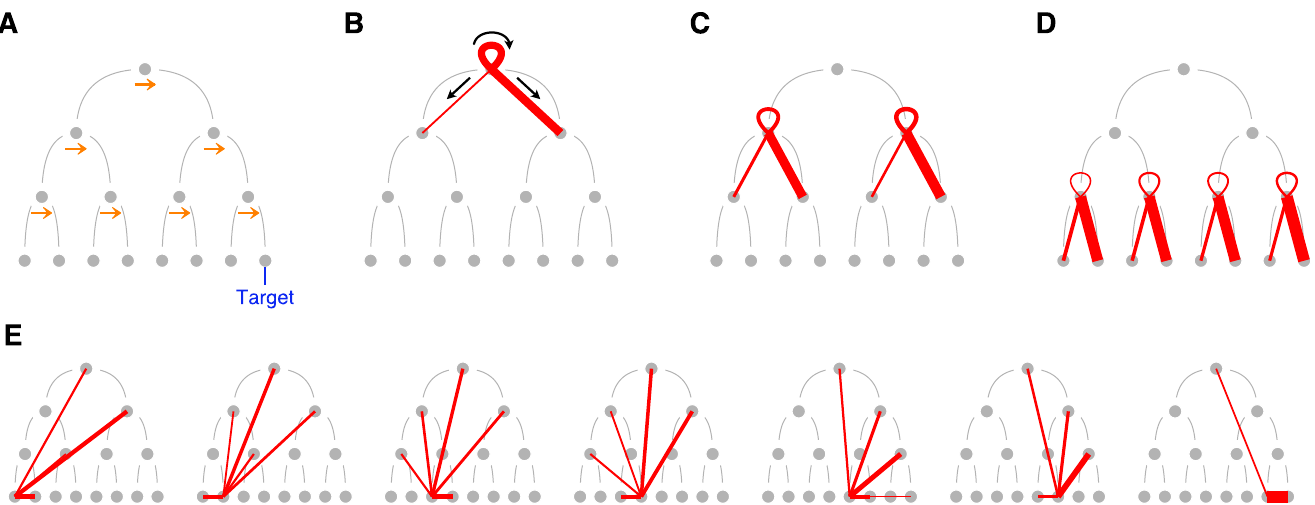
Fig 2. Transition probabilities between nodes of the decision tree. (A) In all the panels, the nodes of the decision tree were re-arranged following the convention depicted in Fig 1D. The re-arrangement can be interpreted as-if rightward were the true direction of motion at every bifurcation (indicated here by the right-pointing arrows). (B-E) Red lines identify the most frequent transitions between pairs of nodes. Transitions from nodes at levels 1–3 are shown in panel B–D, and transitions from leaf nodes are shown in panel E. The width of the line from node x to node y is proportional to the probability of transitioning from x to y given that last query was to node x . Unlikely transitions (conditional probability < 0.075) were omitted. (B–D) After querying an internal node, the more frequent actions were choosing one of the two child-nodes, or re-querying the same node. The ribbon corresponds to re-queries. Because of the notation convention, the true direction of motion is rightward at every internal node. (E) From left to right, transitions from leaf nodes 8 to 14. We excluded the target (node 15) since querying it terminates the trial.